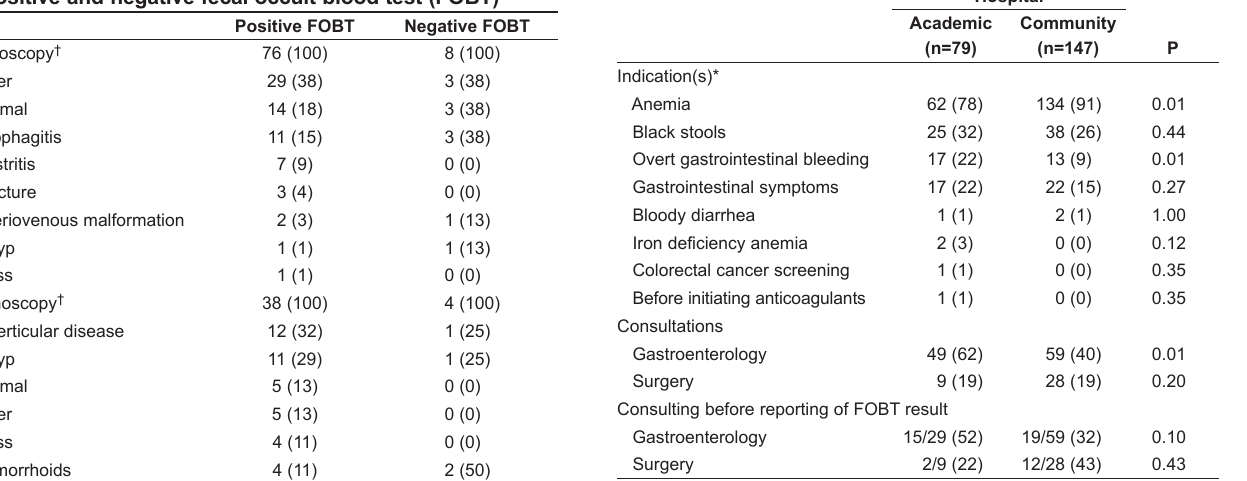
TAble 9 Comparison between academic and community hospitals for admissions with positive fecal occult blood test